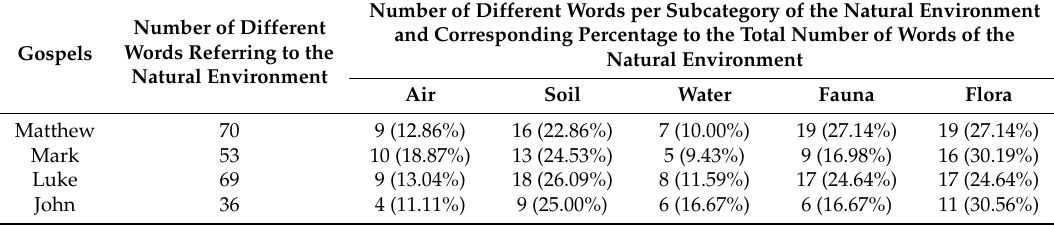
Table 6. Number of unique words referring to the natural environment.